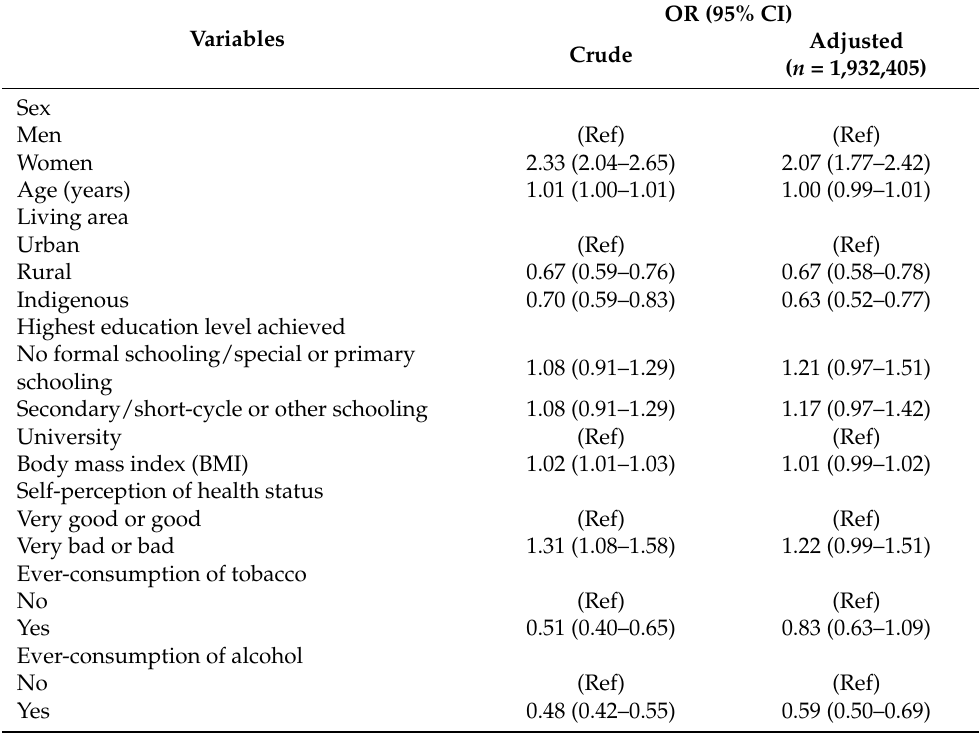
Table 5. Adjusted associations between individual characteristics and physical inactivity among participants aged 18–69 years, presented as odds ratios (OR) and 95% confidence intervals (CI). Panama,